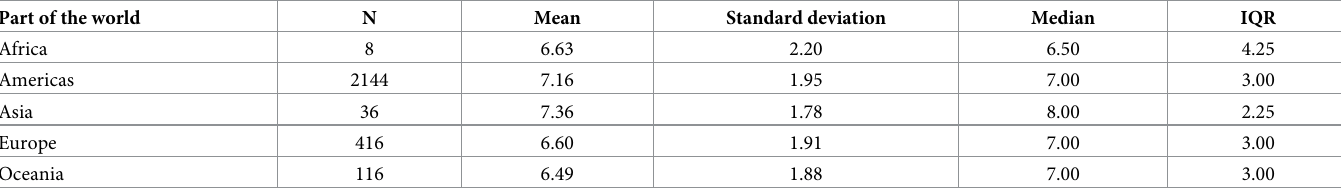
Table 5. Sociability scores by part of the world: Response sample size (n), mean, standard deviation, median, interquartile range (IQR). Part of the